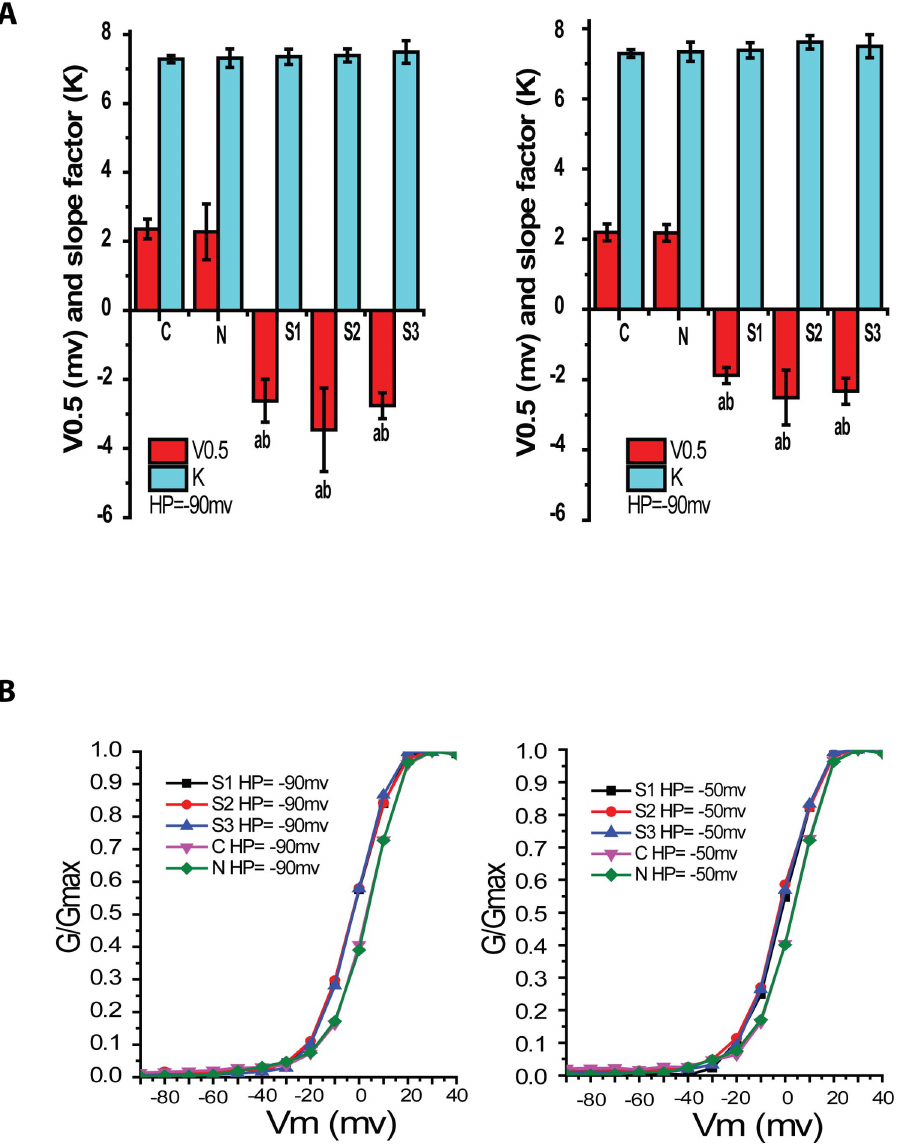
Figure 3. Activation characteristics of VDCCs in rabbit basilar artery smooth muscle cells after SAH. Graph A and B showed steady-state activation curves at HP of 2 90mV and 2 50mV respectively. The abscissa was voltage (mV) and the ordinate was relative conductivity (G). Compared with C and N group, steady-state activation curves of S1–S3 groups at HP of 2 90mV and 2 50mV shifted to the left (p , 0.05, n=8/group).